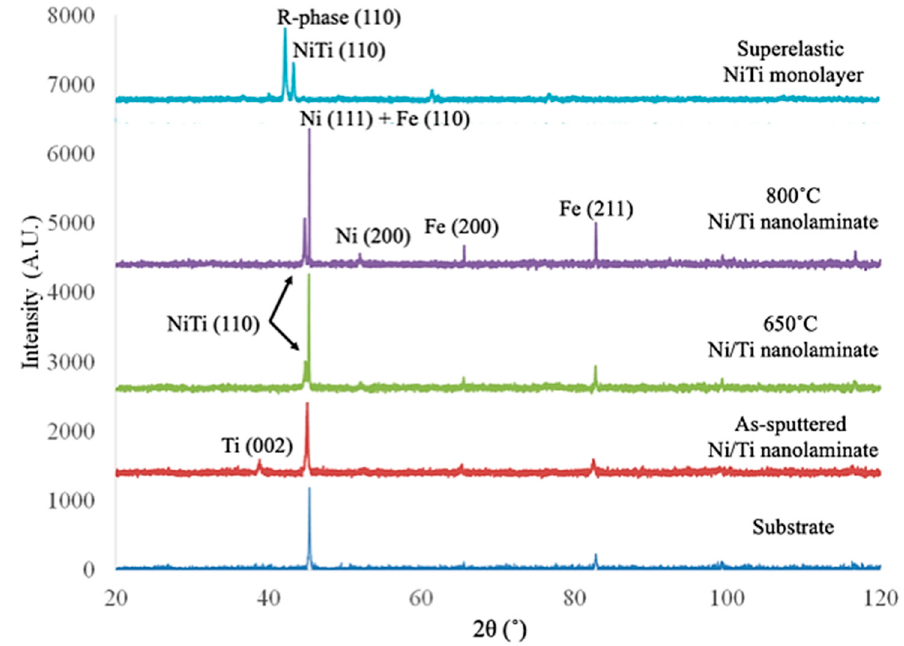
Figure 3. X-ray diffraction (XRD) patterns of nanolaminate coatings.